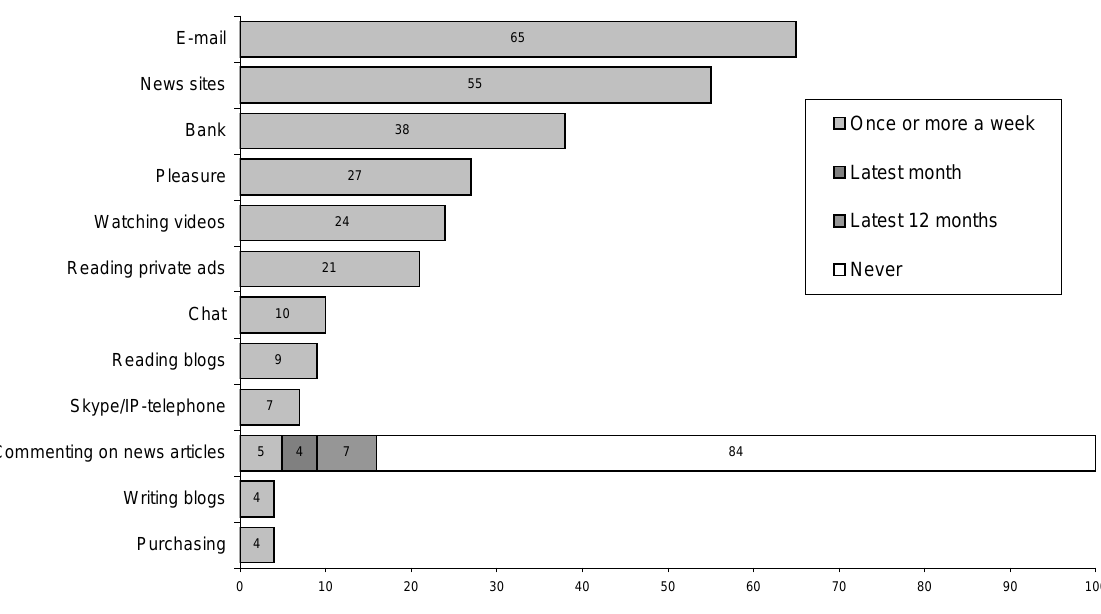
Figure 2: Areas of use on the Internet 2006 (percent)